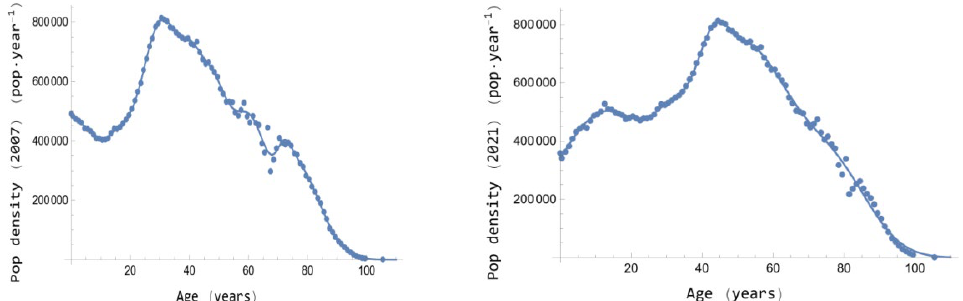
Figure 2. Population densities versus age in Spain for 2007 and 2021 years. Experimental values (dots) and theoretical values (line).